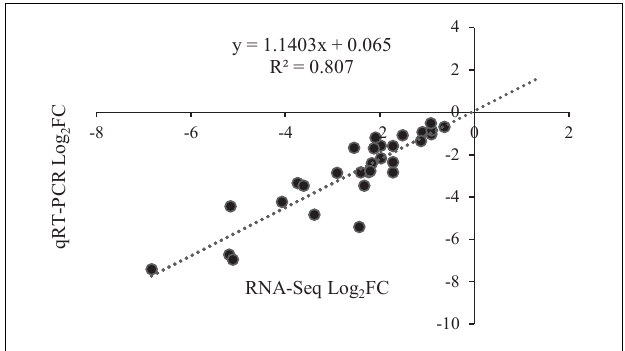
FIGURE 10 | The correlation point map between RNA-Seq and qRT-PCR expression